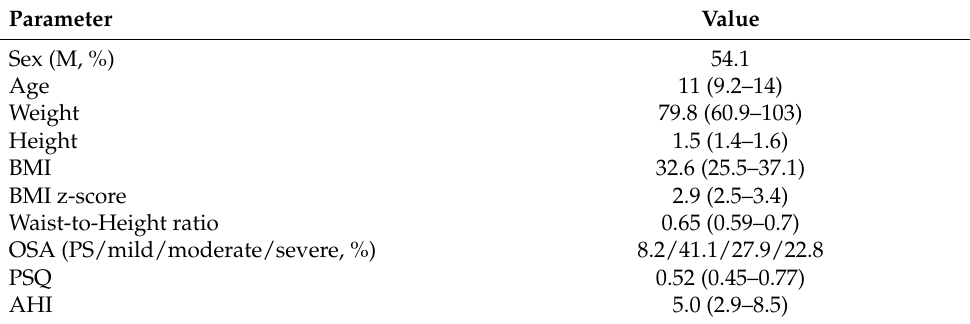
Table 2. Anthropometric and polysomnographic parameters of the cohort.